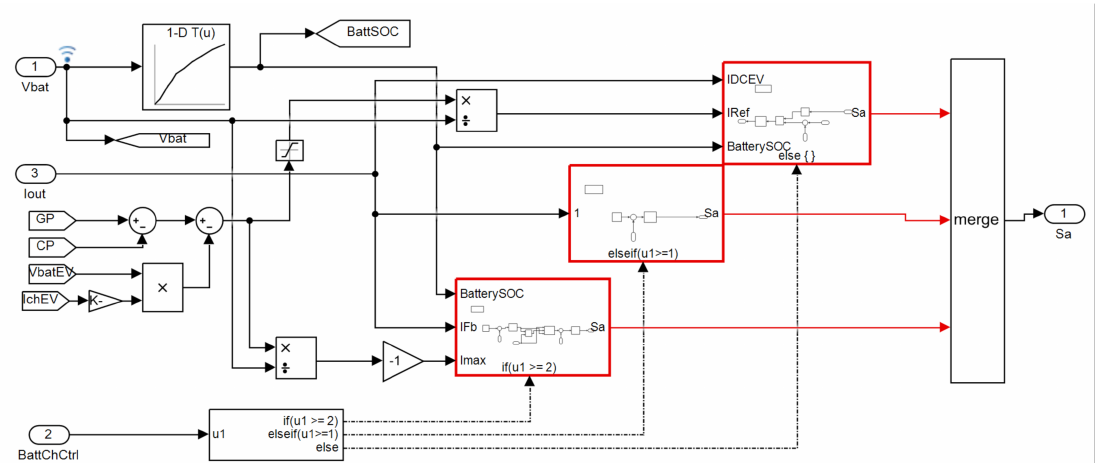
Figure 8. A flowchart discussing the algorithm of the converter connected to the Battery Bank.